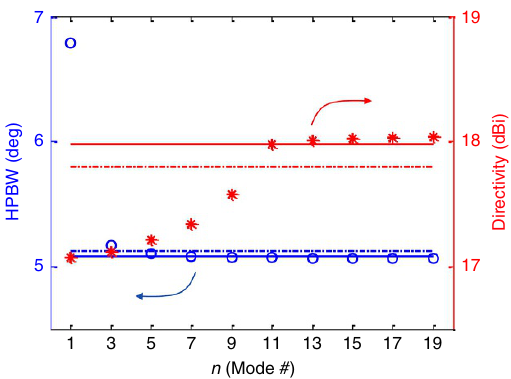
Figure 3 | Radiation characteristics of different lateral cavity modes. Half-power beamwidth (HPBW, blue circles) and 2D directivity 58 (red asterisks) of an HMS aperture of length L ¼ 10 l excited by a single mode as a function of the mode index n . Solid lines denote the respective radiation characteristics of a uniformly excited aperture 29 and dash-dotted lines mark the HPBW (blue) and directivity (red) of multimode excitation corresponding to the HMS antenna of Fig. 1 with L ¼ 10 l , z 0 ¼ (cid:3) l , and d ¼ 1.61 l